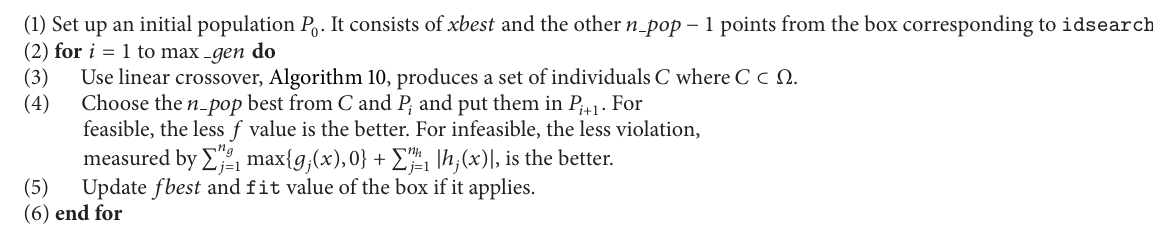
Algorithm 12: GA ( idsearch , max 𝑔𝑒𝑛 , 𝑥𝑏𝑒𝑠𝑡 , 𝑛 𝑝𝑜𝑝 , Ω